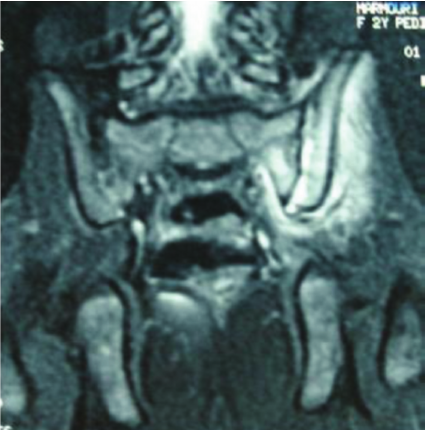
Figure 1: MRI of the pelvis: on T2-weighted images an increase of the signal intensities of the left sacroiliac joint and increase of the signal of the iliacus and gluteal muscles. Also there was a little e ff usion in the left sacroiliac joint.